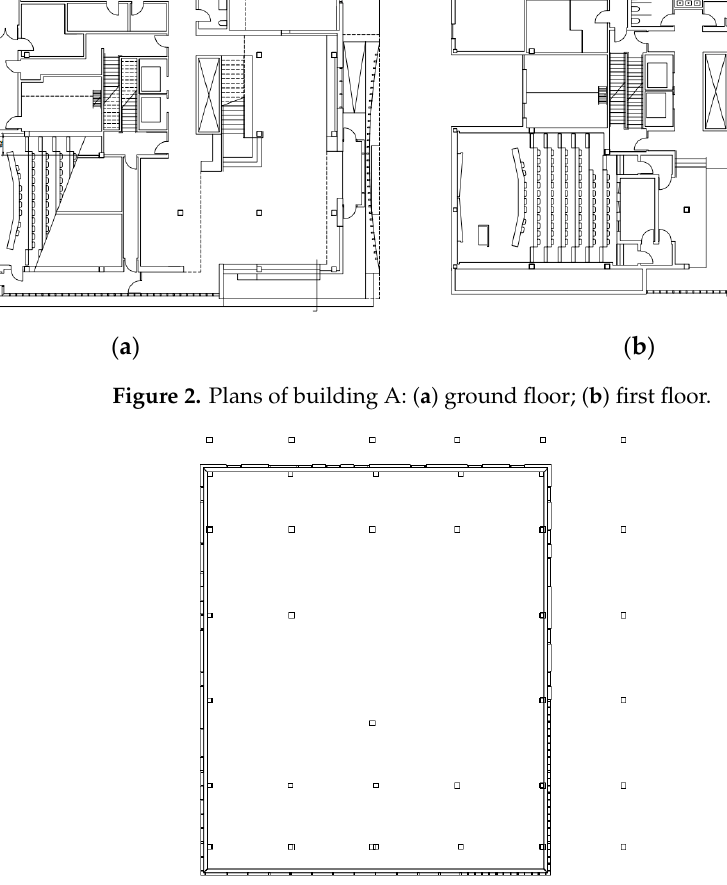
Figure 3. Plan of upper floors of building A and all floors of building B.